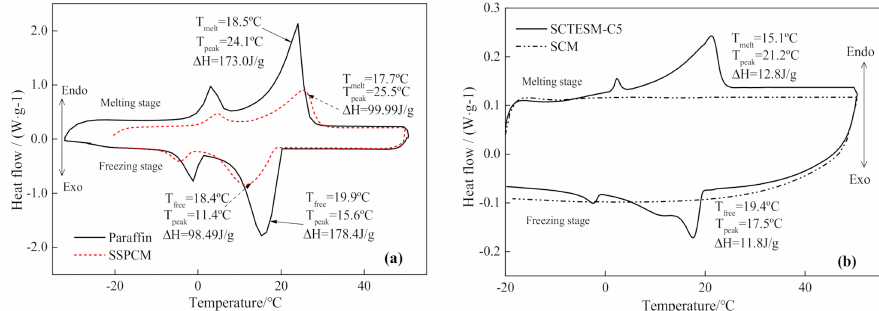
Figure 9. Di ff erential scanning calorimeter (DSC) curves: ( a ) para ffi n and SSPCM; ( b ) SCTESM-C5 and